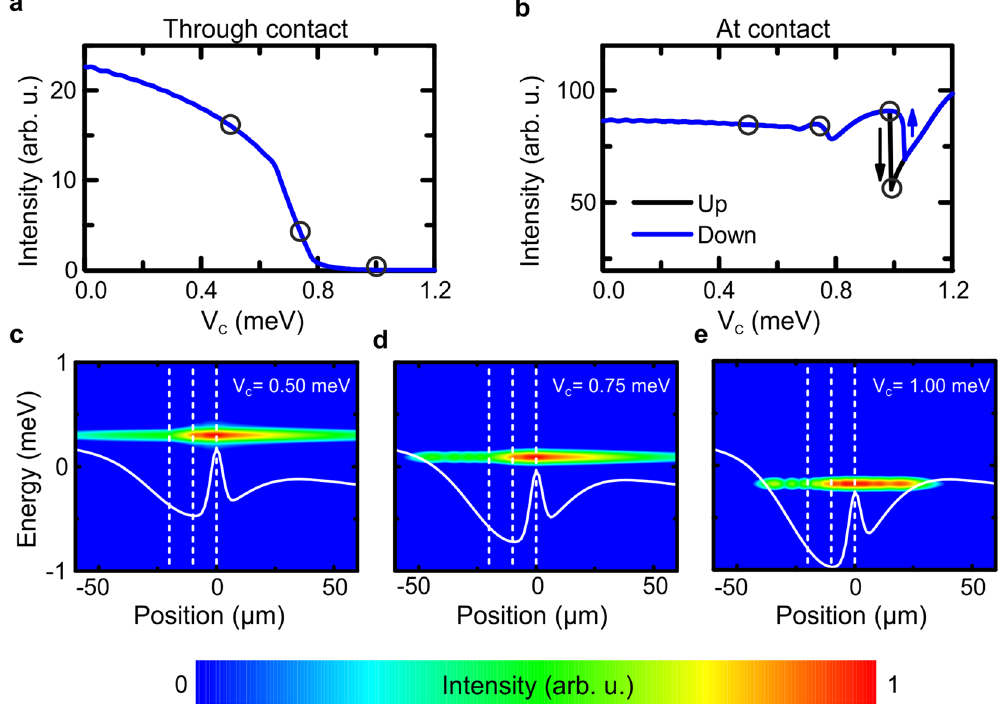
Figure 5. Gross-Pitaevskii model of the experiment. ( a , b ) Total intensity of polaritons that passed the contact ( a ) and before the contact ( b ). ( c – e ) Potential landscape for the injected polariton flow around the contact for different contact-induced potential depths, V C . Without an applied potential dip there is a propagation of polaritons through the contact and away from it ( c ). At a potential depth of ~0.75 meV only the polariton flow through the contact is blocked (asymmetric case) ( d ) while the propagation is finally trapped at higher values of V c ( e